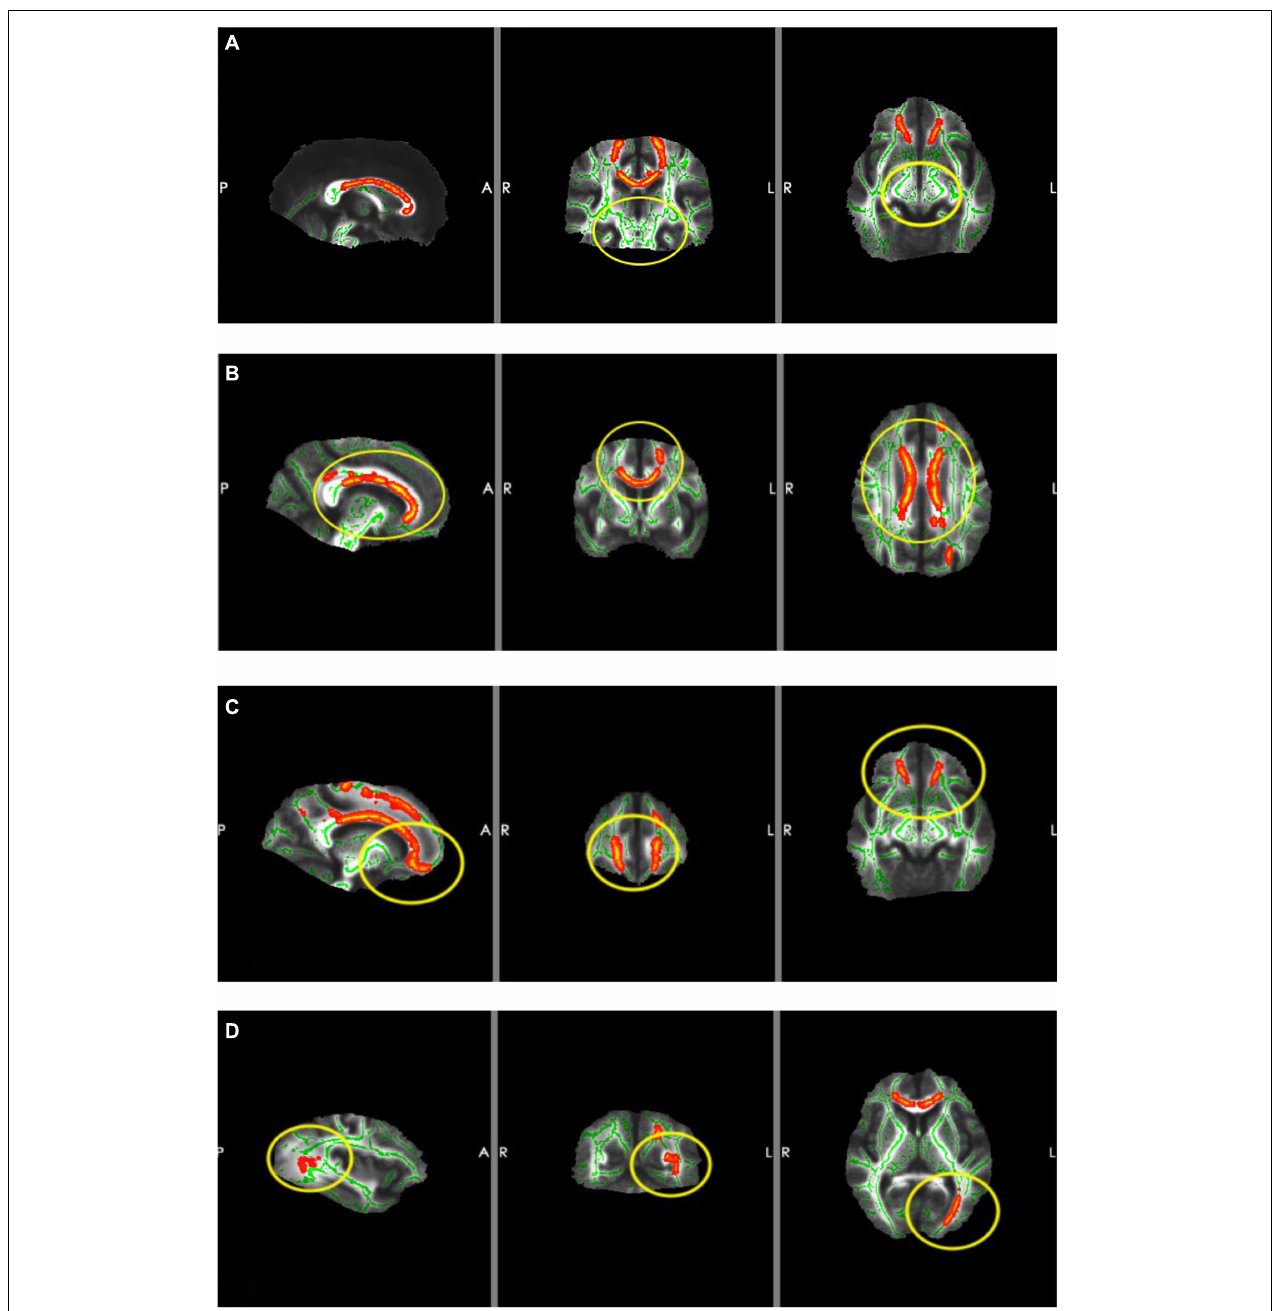
FIGURE 3 | Results of TBSS. The red areas are the areas of lower FA (active area) and the yellow circles are the ROIs. (A) ROI located around the hippocampus (there were no significant changes in FA). (B) ROI located around the corpus callosum (FA was lower in MCI patients). (C) ROI located around the orbitofrontal gyrus (FA was lower in MCI patients). (D) ROI located around the left inferior occipital gyrus (FA was lower in MCI